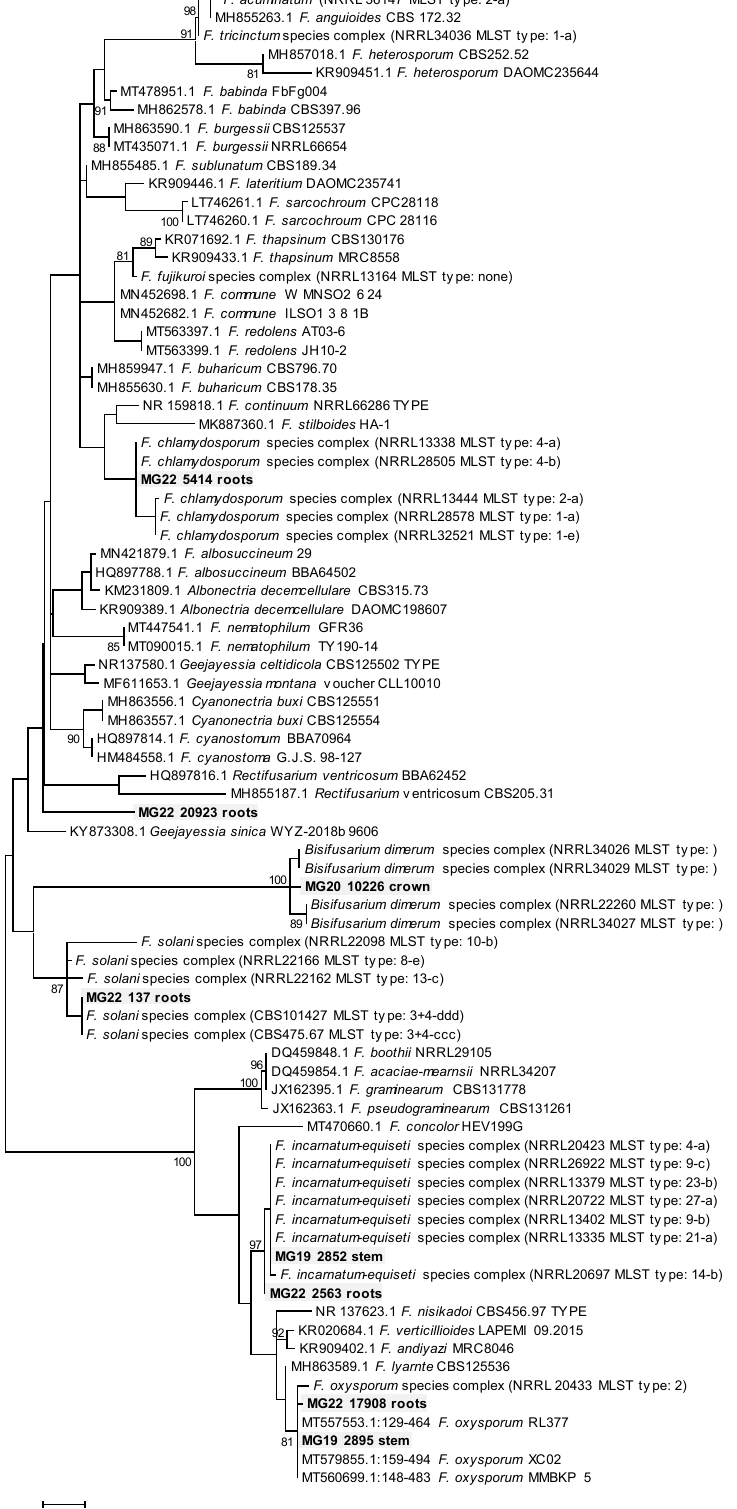
Figure 3. Phylogram of Molecular Operational Taxonomic Units assigned as Fusarium . The phylogram was generated with Maximum Likelihood analyses of the Internal Transcribed Spacer 2 region (used evolutionary model indicated). Confidence levels ≥ 80% (1000 replicate bootstrap analysis) are indicated on the branches. Sequence reads generated in this study are indicated with MG